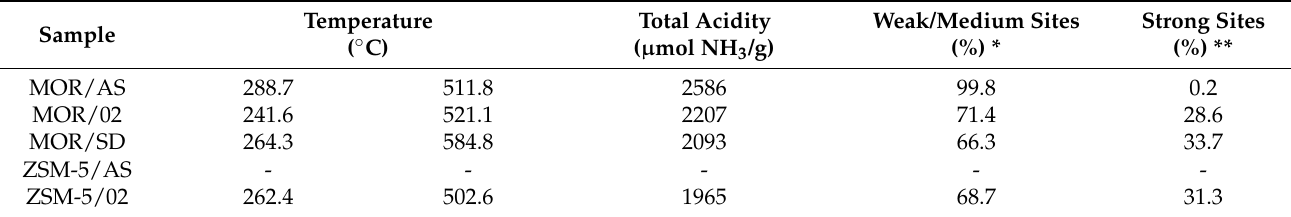
Table 4. Acid properties of catalysts obtained by TPD-NH 3